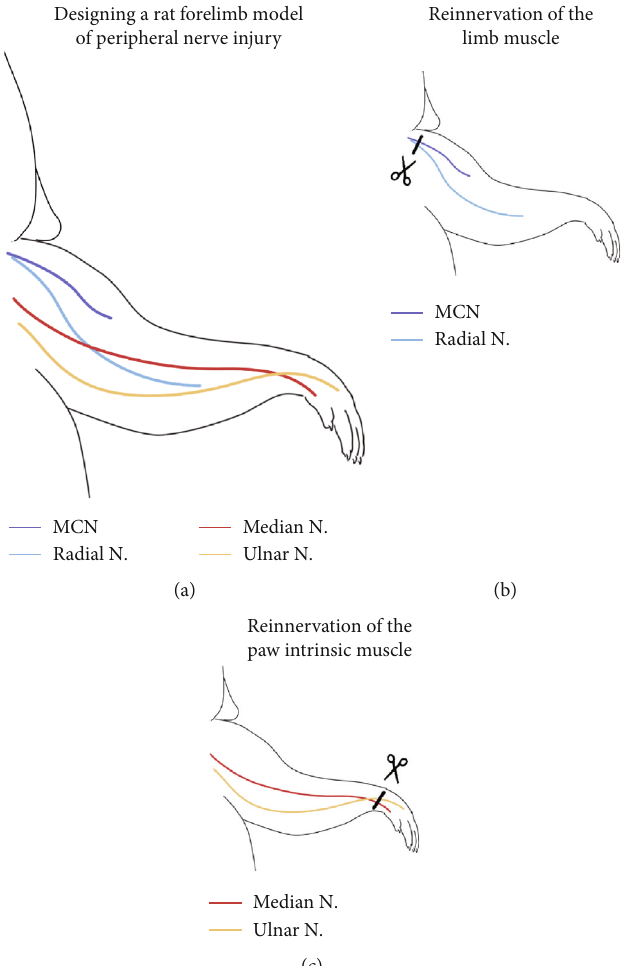
Figure 1: The surgical procedure of the raw forepaw. (a) To assess the skilled functional recovery outcome after peripheral neural repair, we designed a nerve anastomosis model using rat forelimb. (b) The musculocutaneous nerve (MCN) and radial nerve of the rat forelimb were resected with or without nerve repair, to investigate the impact of limb muscle denervation and reinnervation on the skilled limb function. (c) Similarly, the median nerve and the ulnar nerve were manipulated to study the denervation and reinnervation of the paw intrinsic muscle. Table 1: Establishing the optimal sequencing parameter for measuring the forepaw intrinsic muscle volume. Resolution Parameter Sequence